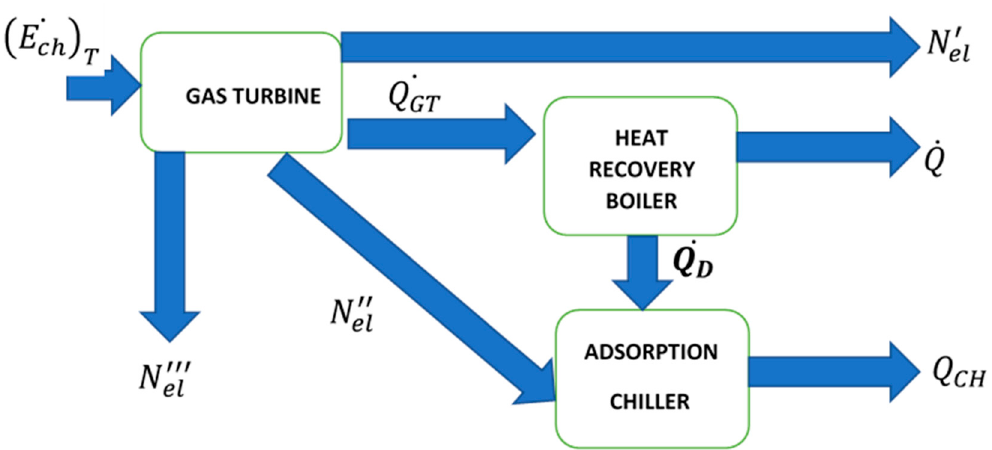
Figure 6. Simplified schematic diagram of a trigeneration-polygeneration system with a gas turbine, recovery boiler and adsorption chiller [7].